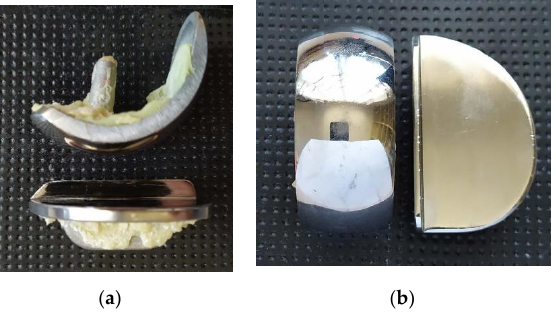
Figure 6. Research material: unicompartmental knee joint endoprosthesis, a) components of endoprostheses, b) the surfaces of a metal–metal contact.